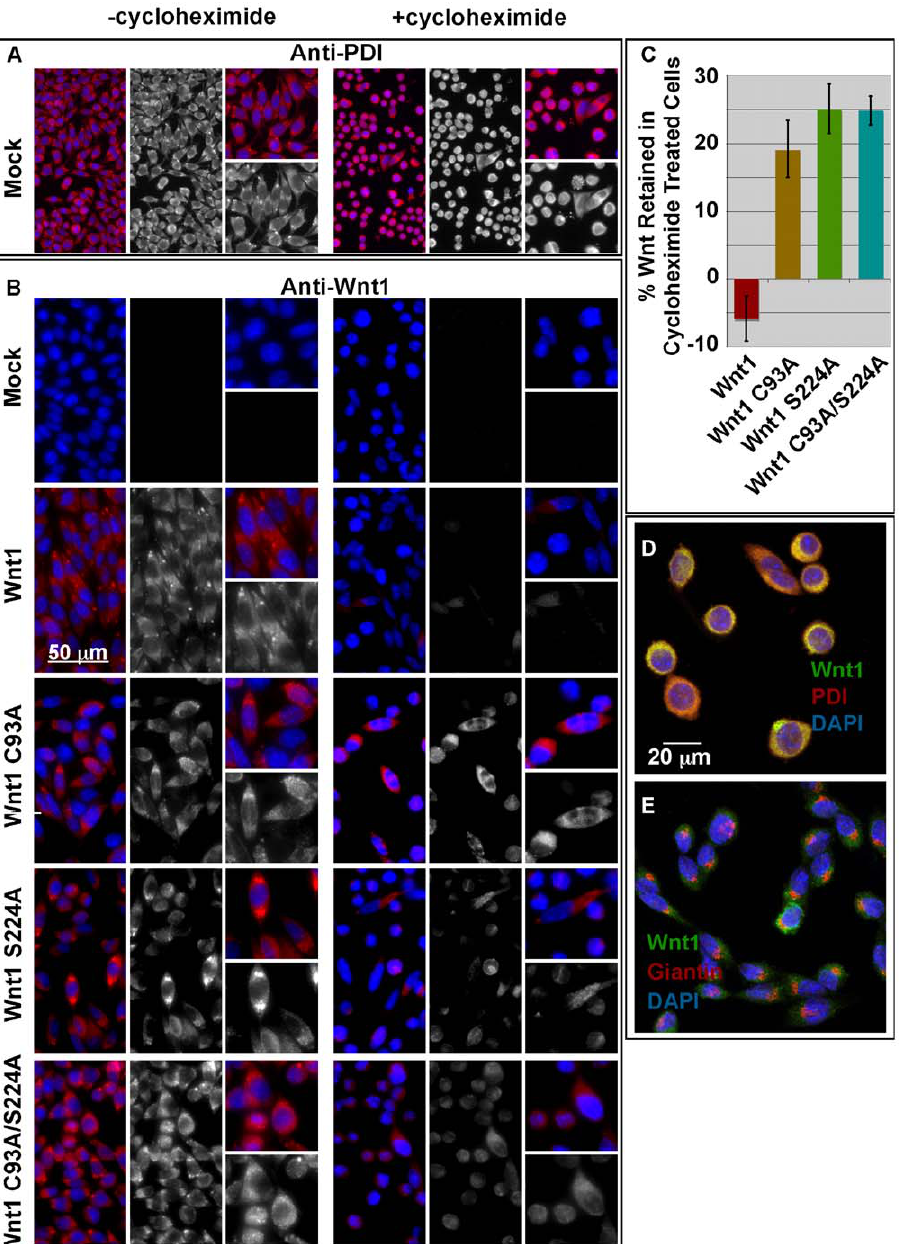
Figure 4. Mutation of the cysteine and/or serine causes an accumulation of Wnt protein in the endoplasmic reticulum. Stably transfected L cells were grown in the presence ( + cycloheximide) and absence (-cycloheximide) for 14–21 hours. Cells were then fixed and stained for PDI ( Panel A ) or Wnt1 ( Panel B ). Images were collected with a SPOT camera attached to a Nikon E600 compound microscope. A scale bar is shown for reference. This experiment was carried out twice. Panel C: For quantitation of these studies, images were collected via confocal microscopy. Fields for imagingwere selected whilevisualizing only theDAPI channel. NIHImageJ was used to measure thecell intensities intheWnt1 channel. The data shown represents the sum of 3 independent replicates with a total of 9 fields counted (3 for each replicate). At least 120 cells were counted for each data point. Error bars indicate + / 2 standard error. In Panels D and E , confocal analysis of Wnt1 C93A/S224A of cycloheximide treated cells is shown. Cells were immunostained with anti-Wnt1 (green), anti-PDI (red; Panel D ), and anti-Giantin (red; Panel E ). DAPI (blue) was used to visualize the